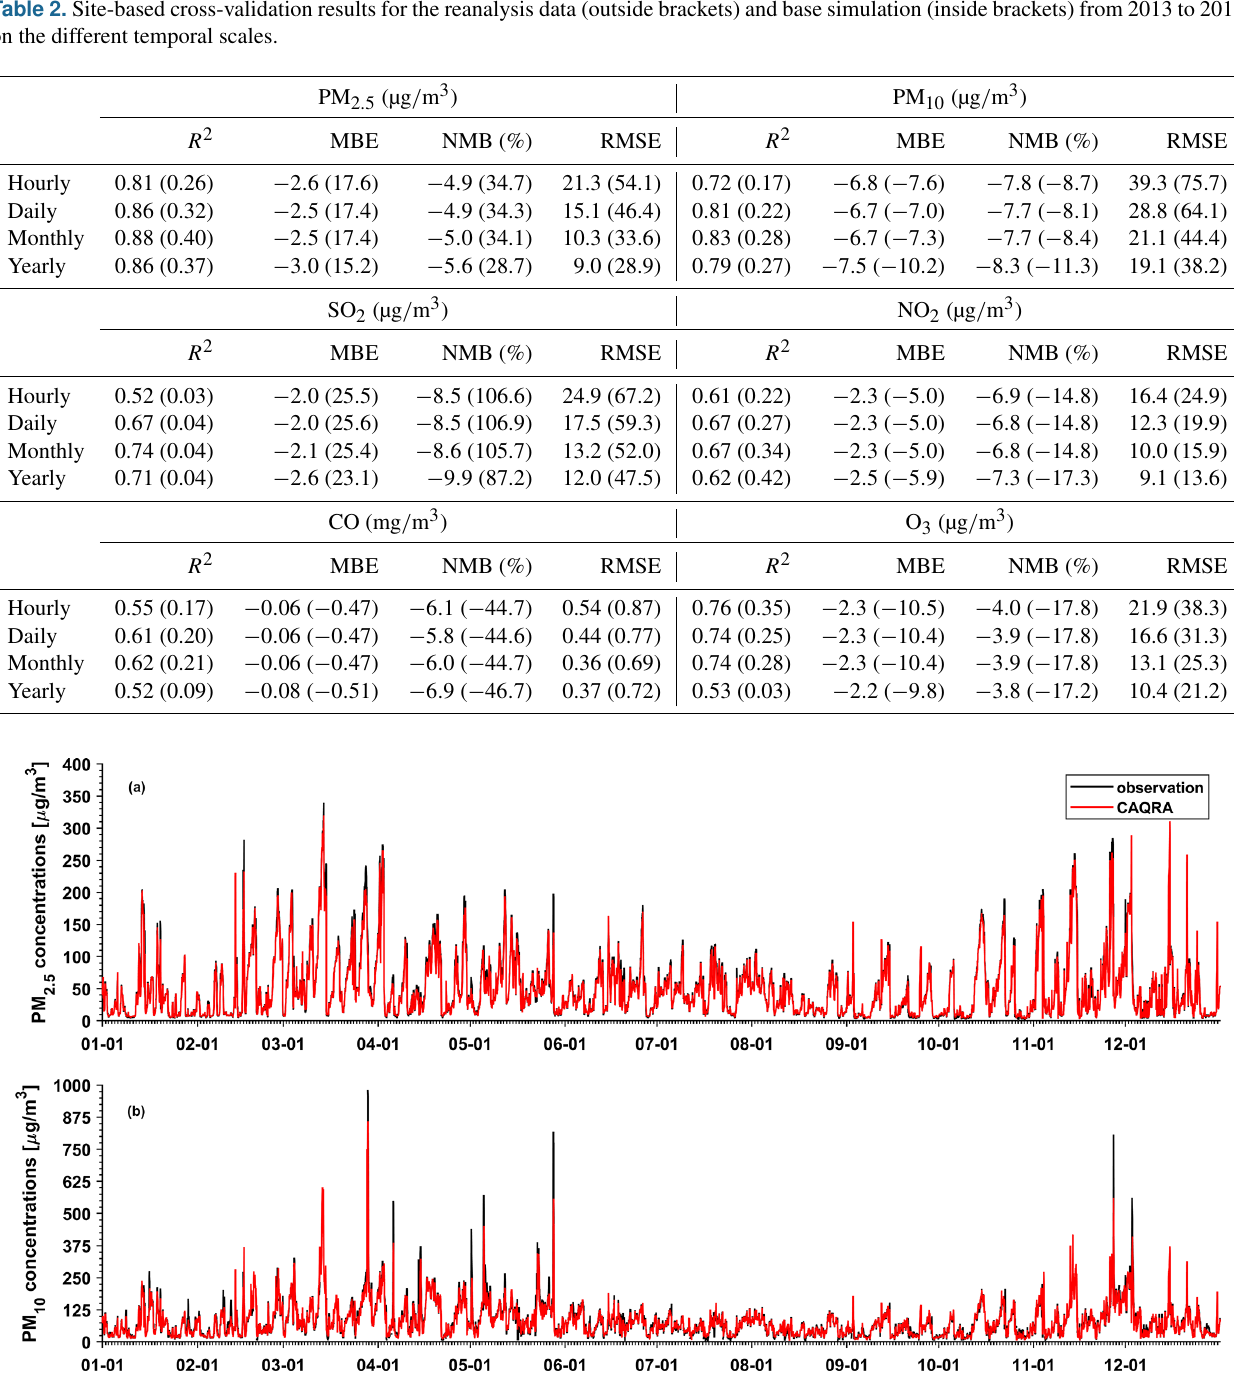
increasing to approximately 18.0 and 14.1 %,